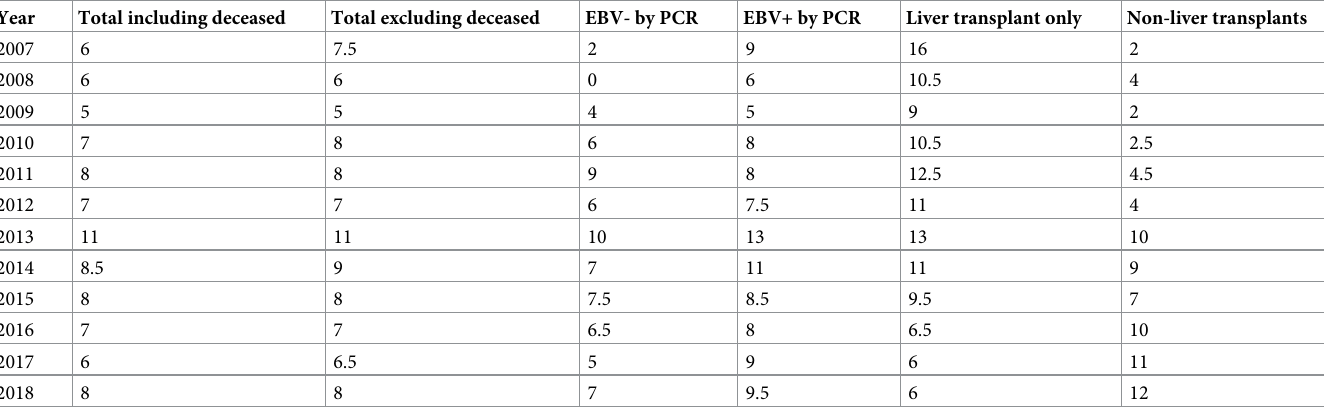
Table 8. Median number of tests done per subject, stratified by year and only including tests done within first year